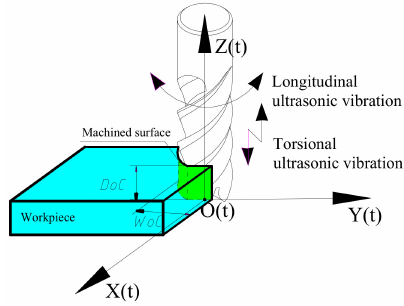
Figure 1. Longitudinal-torsional ultrasonic vibration-assisted milling.